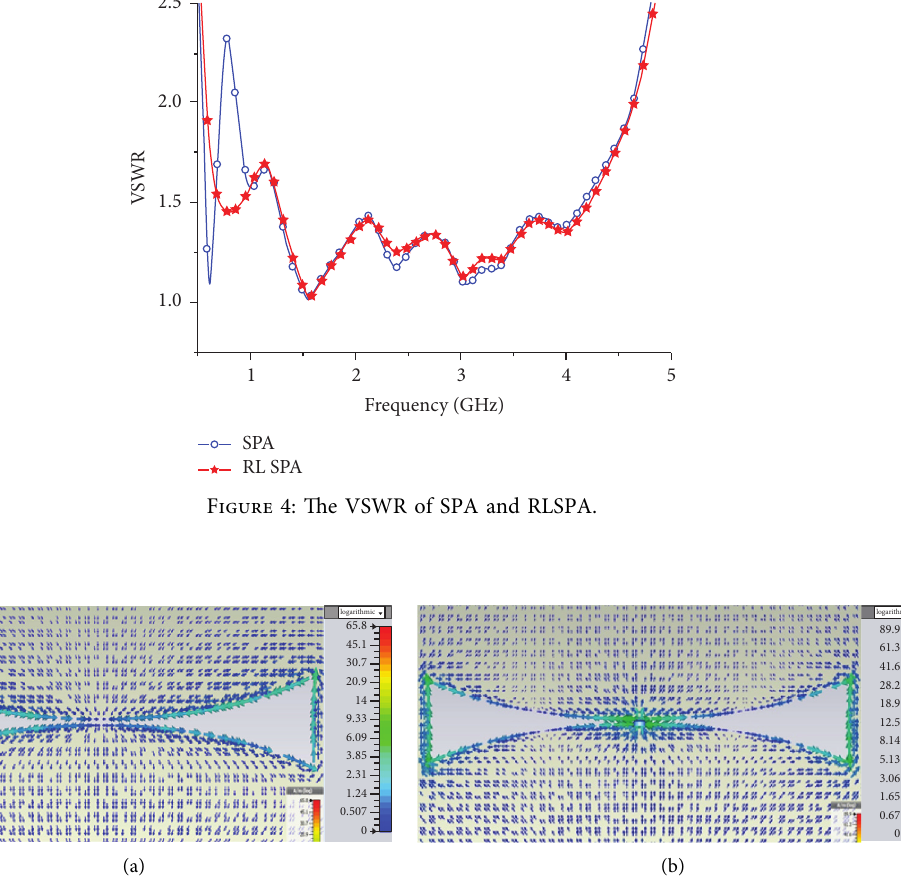
Figure 5: Construction of the antenna: (a) top radiator and (b) bottom view (ground